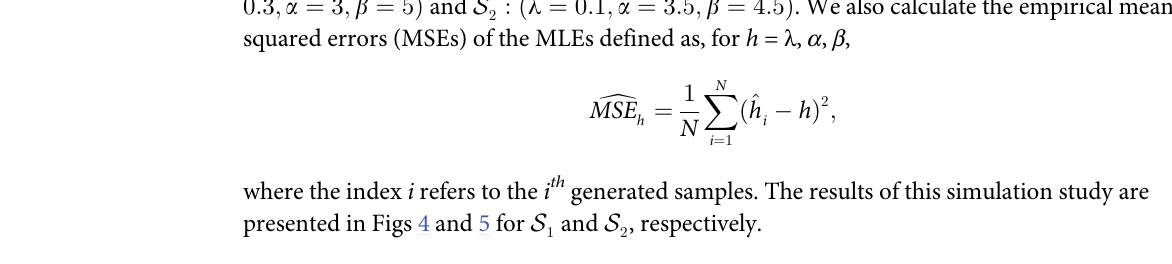
: ð λ ¼ 0 : 3 ; α ¼ 3 ; β ¼ 5 Þ for (a) λ , (b) α and (c) β . 1